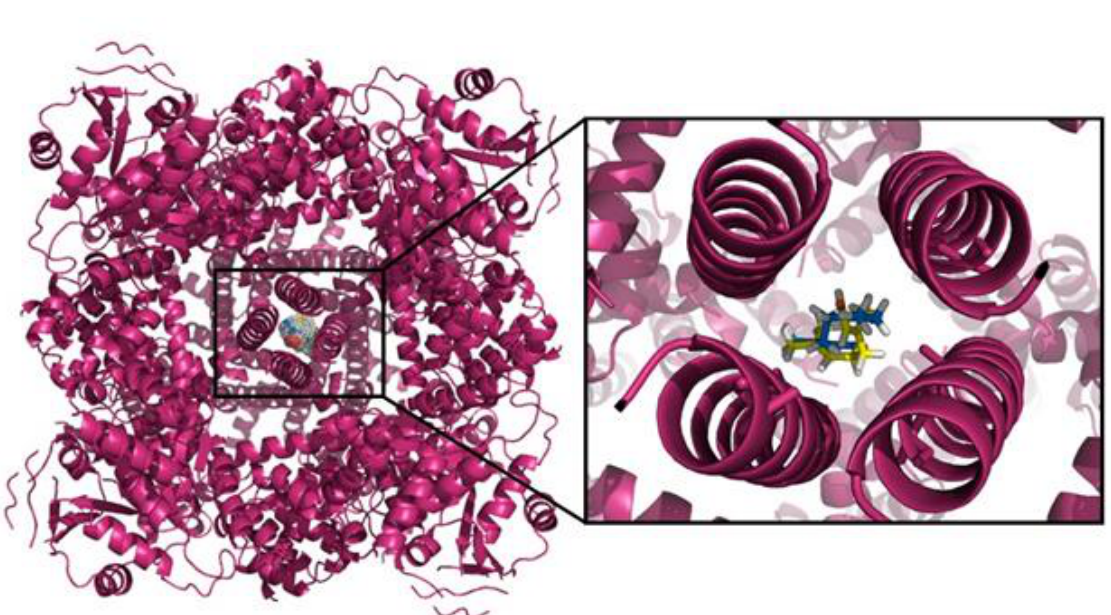
Figure 9: Neral (blue sticks) and geranial (yellow sticks) isomers interacting specifically with the TRPM8 channel, in the central region, rich in alpha-helix structures.